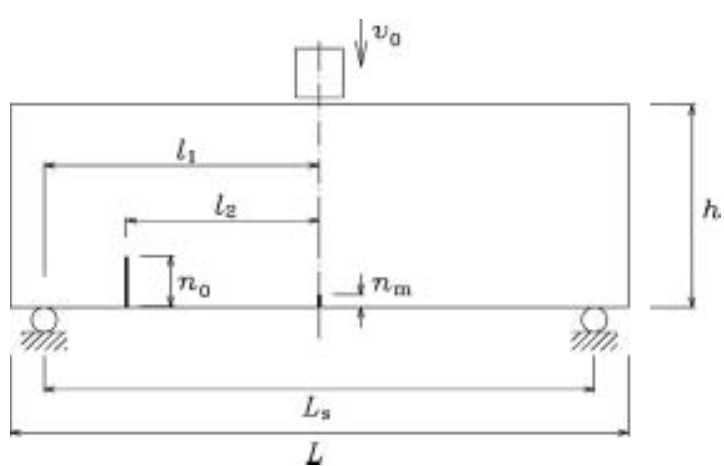
Fig. 6. A 3-node triangle element with a discontinuous displacement field.